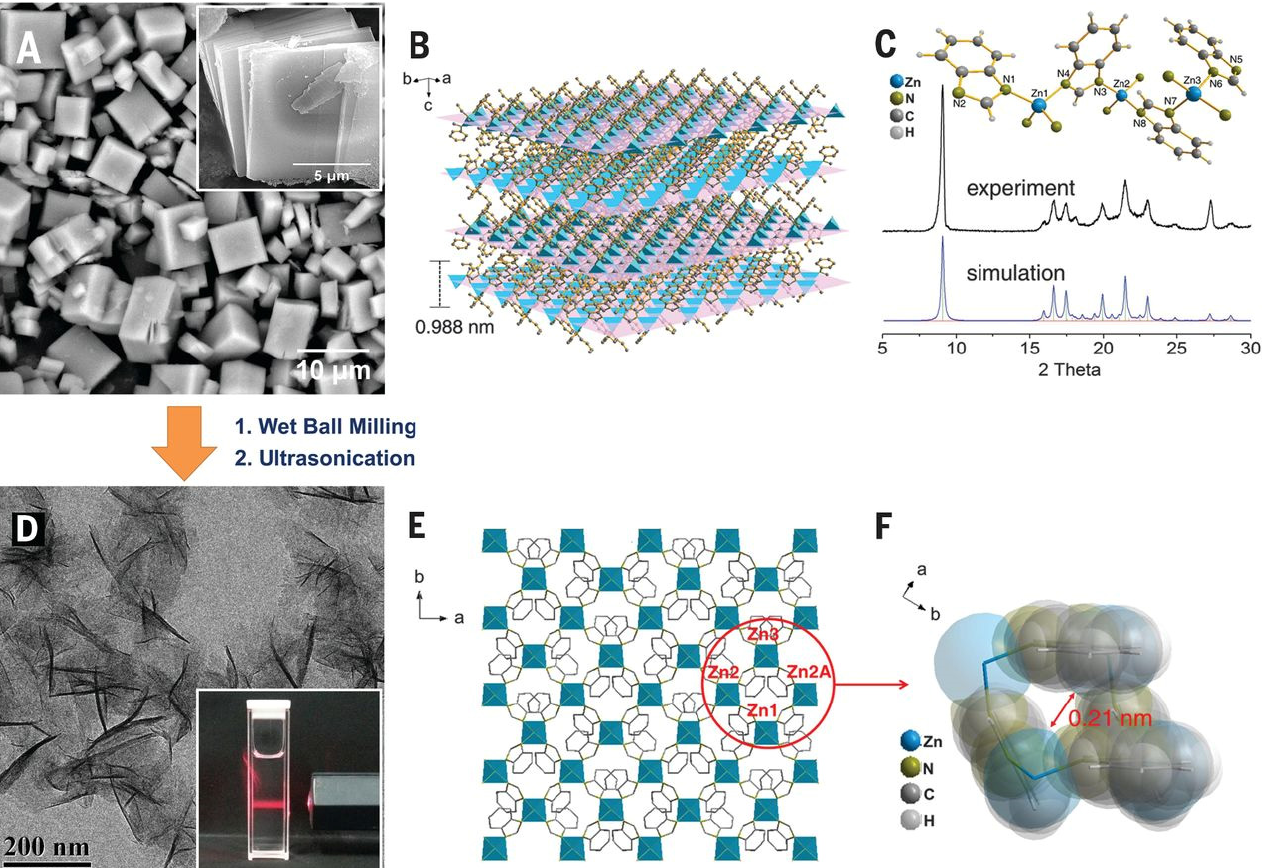
Figure 5. Top ‐ down synthesis of Zn 2 (BIM) 4 nanosheets from its corresponding crystals. The scanning electron microscopy (SEM) images of the crystals are shown in ( A ) with the layered structure clearly visible in the inset. The top ‐ down treatment (wet ball milling + ultrasonication) exfoliates it into nanosheets as observed from the transmission electron microcopy (TEM) images ( D ). The inset in ( D ) shows the Tyndall effect exhibited by its colloidal suspension. The phase formation of the prepared MOFs is confirmed by X ‐ ray diffraction ( C ). The schematic representation of the MOF architecture before and after the exfoliation treatment is shown in ( B , E ), respectively. ( F ) represents the space ‐ filling model of a four ‐ membered ring of the MOF nanosheet. From [60]. Reprinted with permission from AAAS.